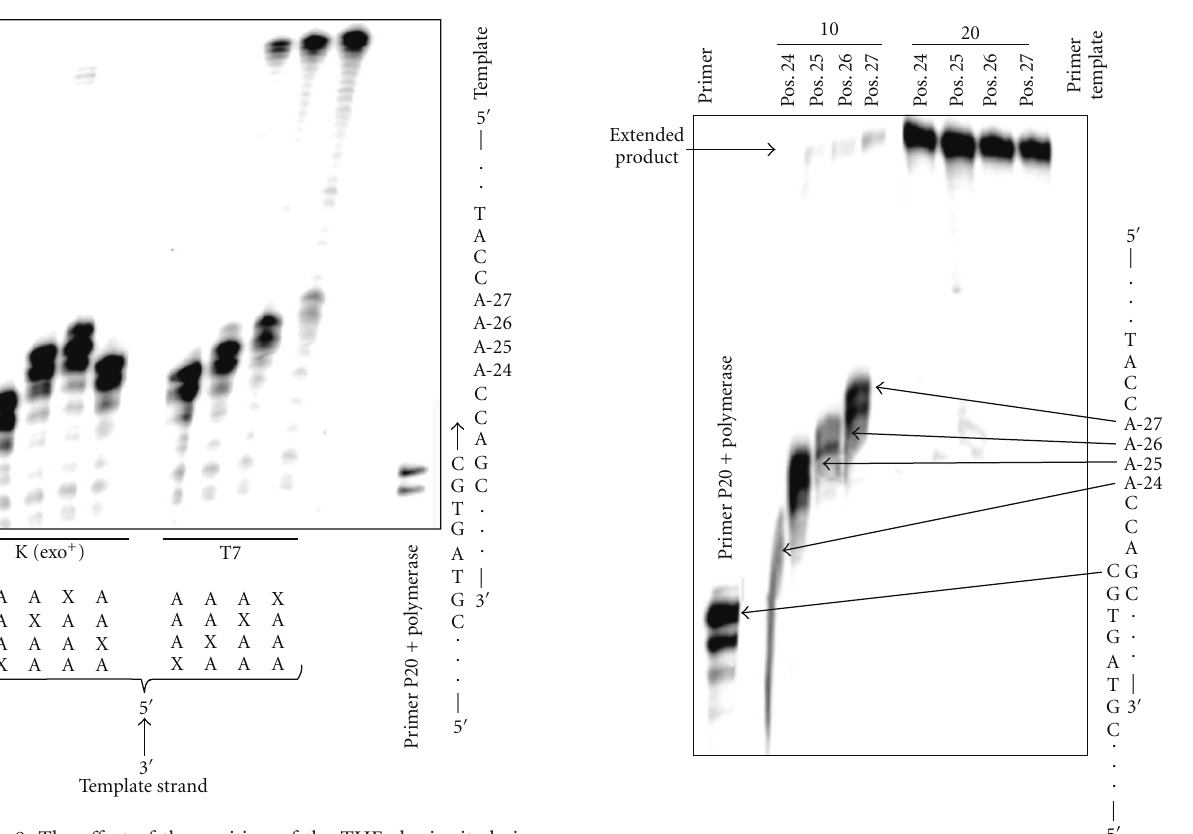
Figure 9: The e ff ect of the position of the THF abasic site lesion within the A 4 tract on the insertion and extension by Klenow fragment (exo + ) (K) and T7 Sequenase (T7). The location of the THF lesion (X) is shown below the lane. The primer (Table 1, P20) is shown paired to a partial sequence of the template. There is no bypass of the THF-modification using the proofreading Klenow polymerase. When T7 Sequenase is used, the extent of stalling and extended product is dependent on the position of the lesion within the A-tract.